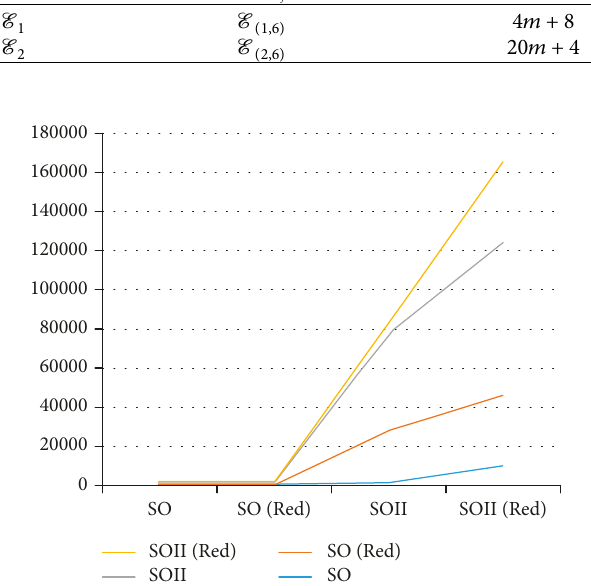
Figure 3: Graphical comparison of SO , SO